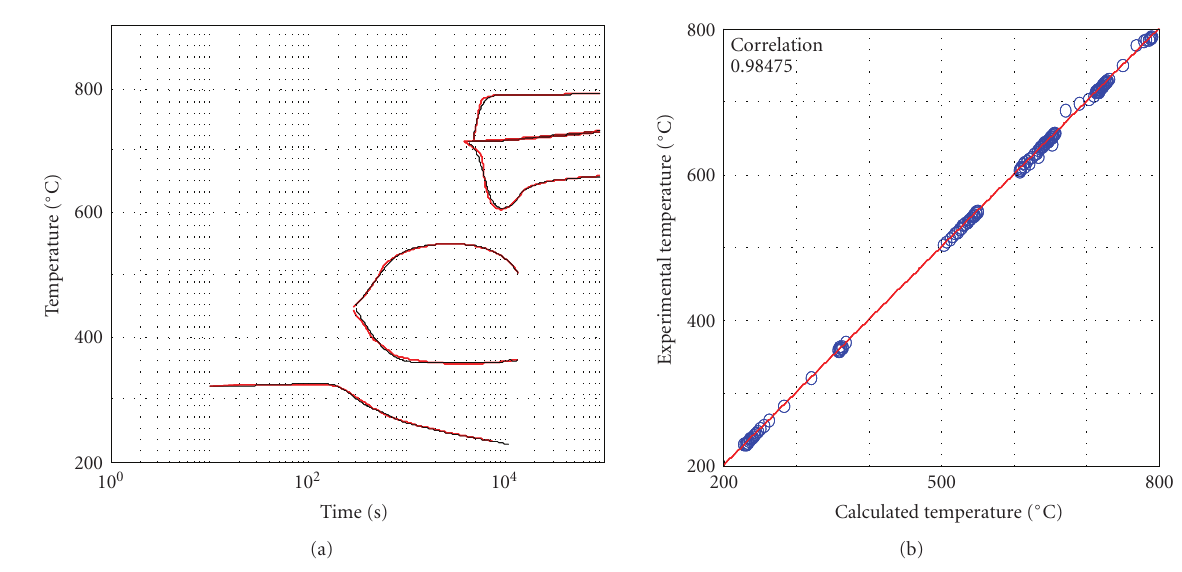
Figure 10: Results for tempering steel 42CrMo4 with a deformation of